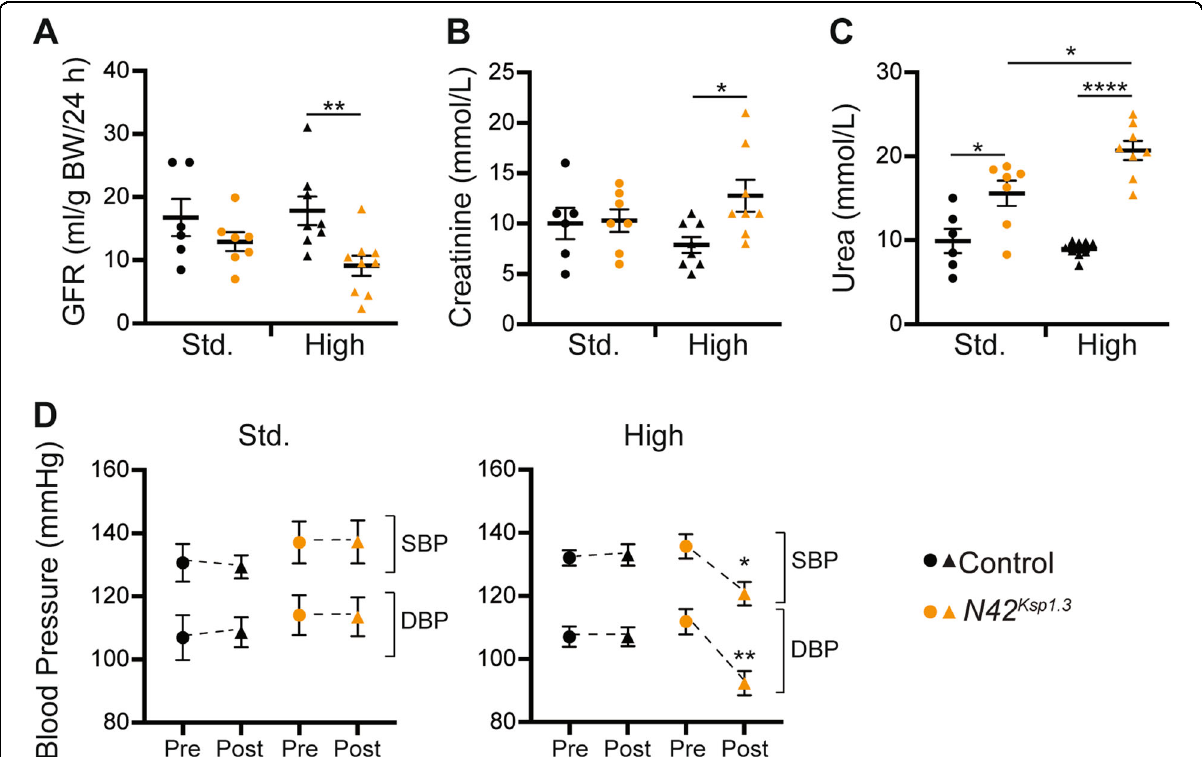
Fig. 1 High dietary Na + exacerbates renal disease in Nedd4-2 Ksp1.3 mice, independently of hypertension. A GFR calculated from 24 h urine and blood collection after 17 days of standard (Std.) or high Na + diet. B , C Serum creatinine and urea levels after varied diets. D BP measured by noninvasive tail-cuff averaged over 3 days for each time point. Pre: before the commencement of diet, Post: at the conclusion of varied Na + diet. SBP systolic blood pressure, DBP diastolic blood pressure. A – C Signi fi cance determined using an unpaired two-tailed Student ’ s t test (means ± SEM). D Signi fi cance determined using one-way ANOVA of repeated measurements (means± SEM, n = 9 – 11). * P < 0.05, ** P < 0.01, **** P <